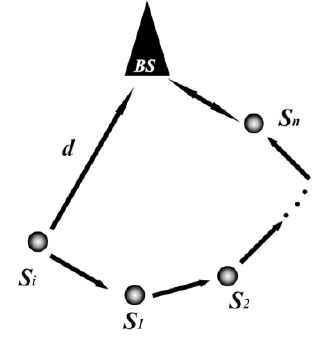
Figure 10. Comparison of direct and multi-hops